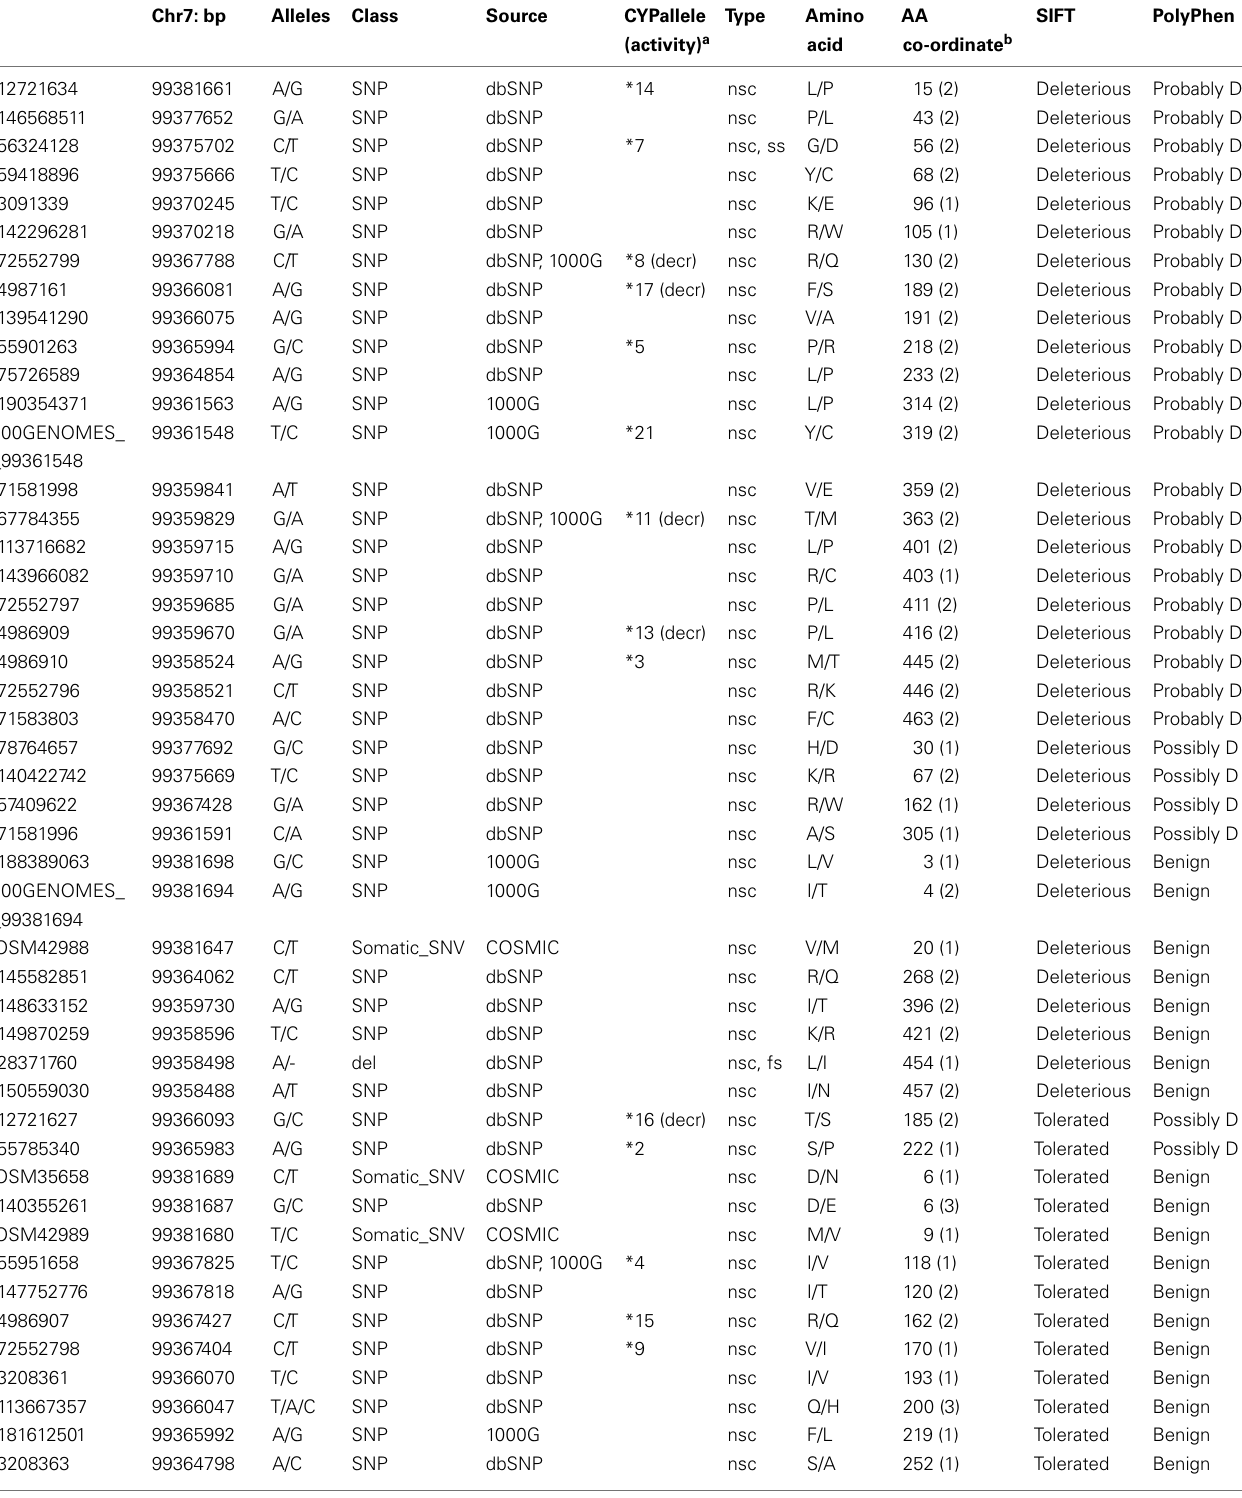
Table 3 | CYP3A4 coding SNPs provided by the 1000 Genomes Project (selected are the SNPs for the major transcript ENST00000336411 from http://browser.1000genomes.org/Homo_sapiens/Search/Results?site = ensembl&q = cyp3a4) accessedSeptember